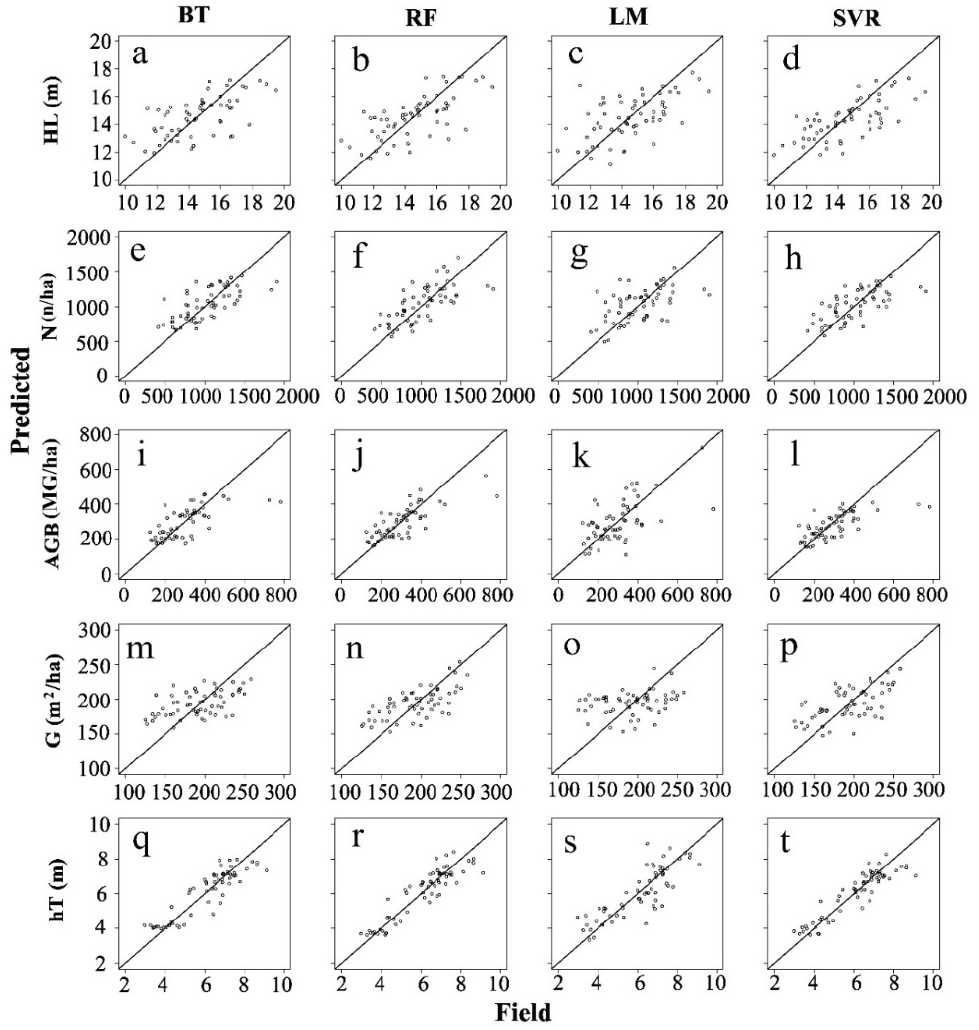
Figure 5. Each regression result for the forest structural parameters of the canopy trees.